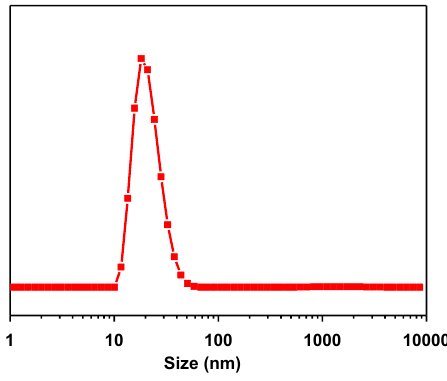
Figure 6. Hydrodynamic diameter of P(BPMA- co -ProHEMA) gel - b -PMMA in THF (0.2 mg/mL) calculated from dynamic light scattering result.